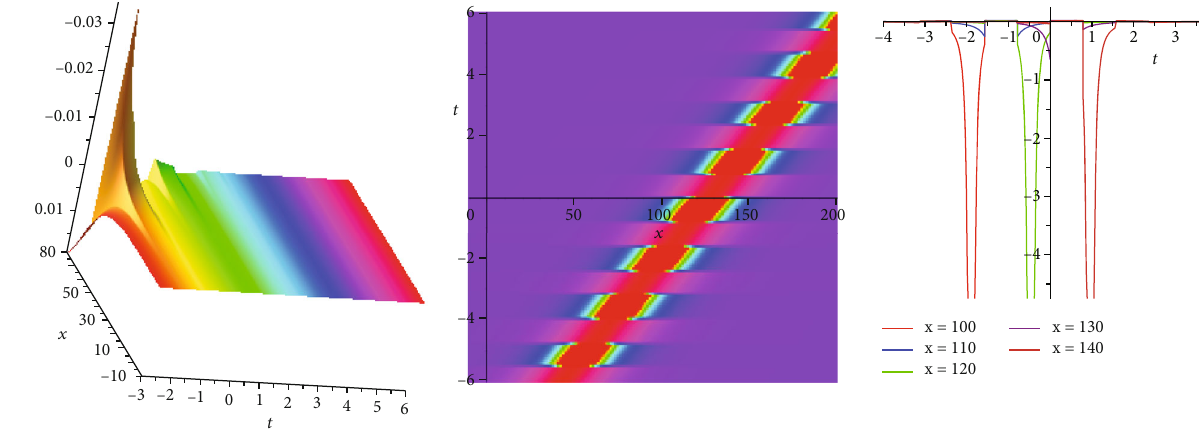
Þ (3D plot, density plot, and 2D plot t ), respectively. 6